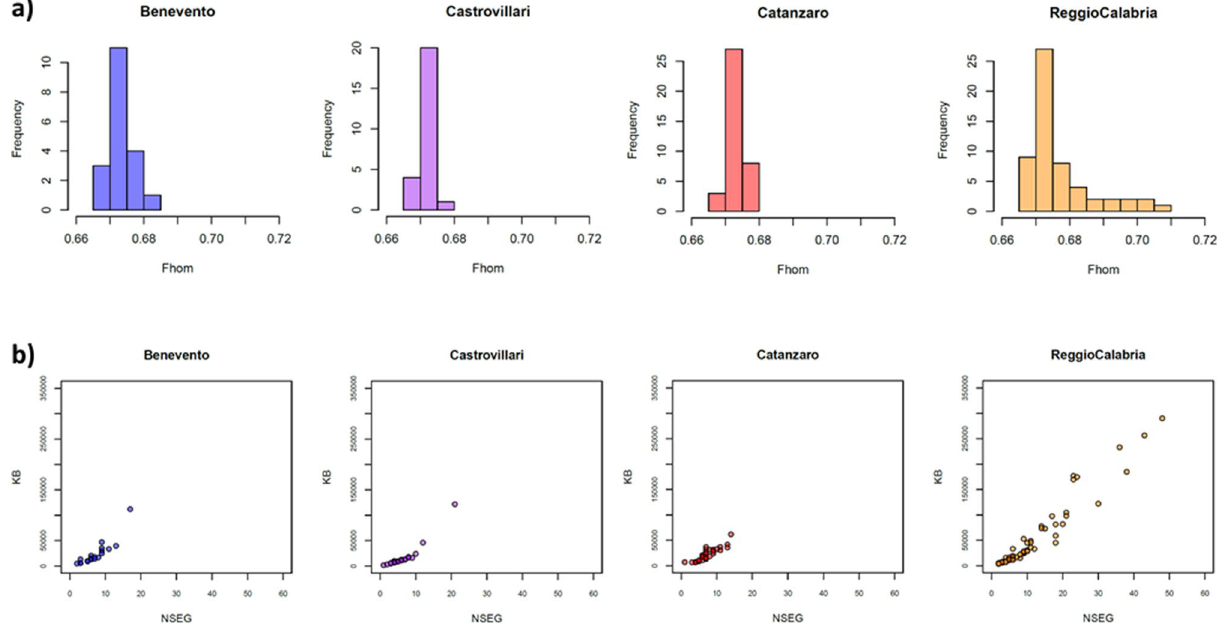
Figure 3. Intra-population patterns of genetic variation in the newly analyzed Southern Italian populations. ( a ) Distribution of genome-wide homozygosity index Fhom and ( b ) total length of ROHs (KB) plotted against number of ROHs (NSEG). Color-code as follow: Benevento ( blue ), Castrovillari ( purple ), Catanzaro ( magenta ) and Aspromonte area of Reggio Calabria ( orange